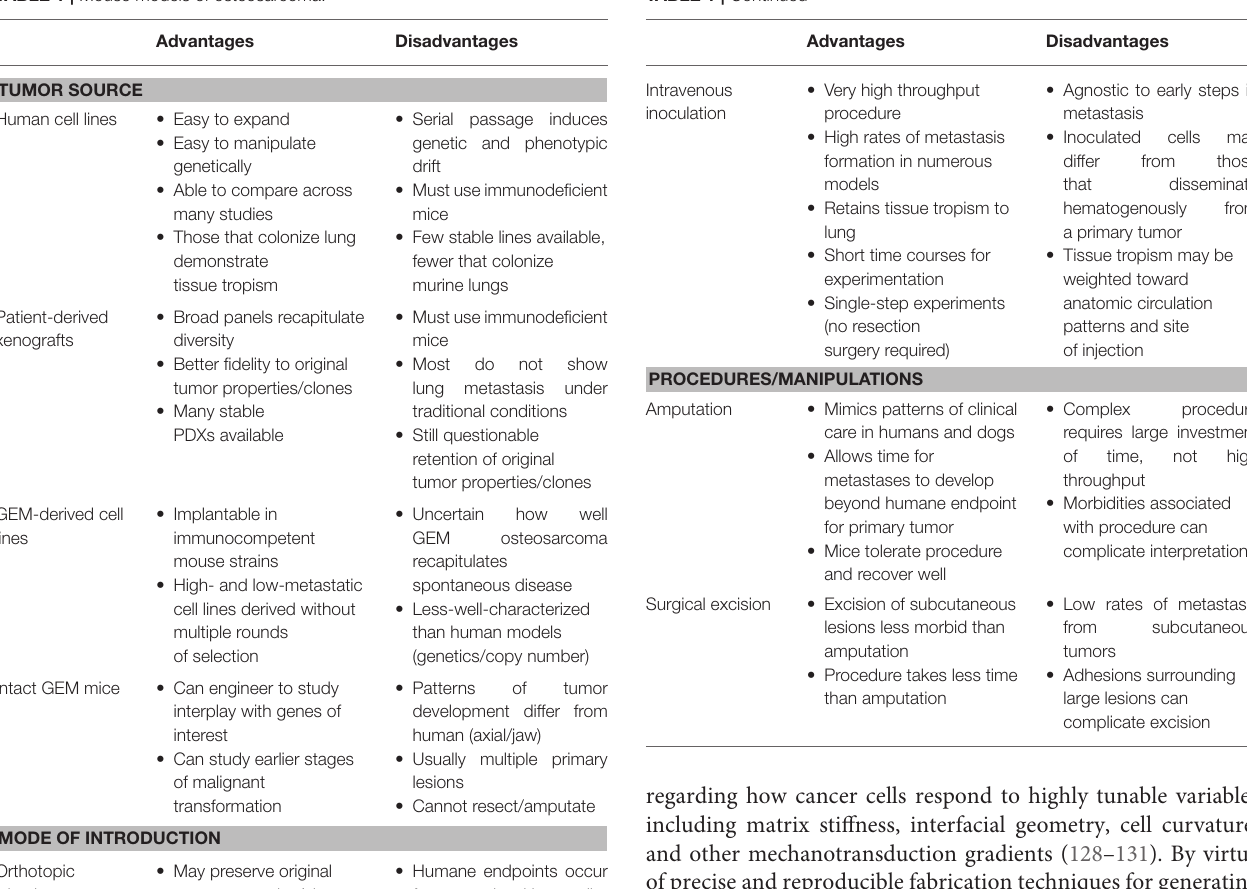
TABLE 1 | Mouse models of